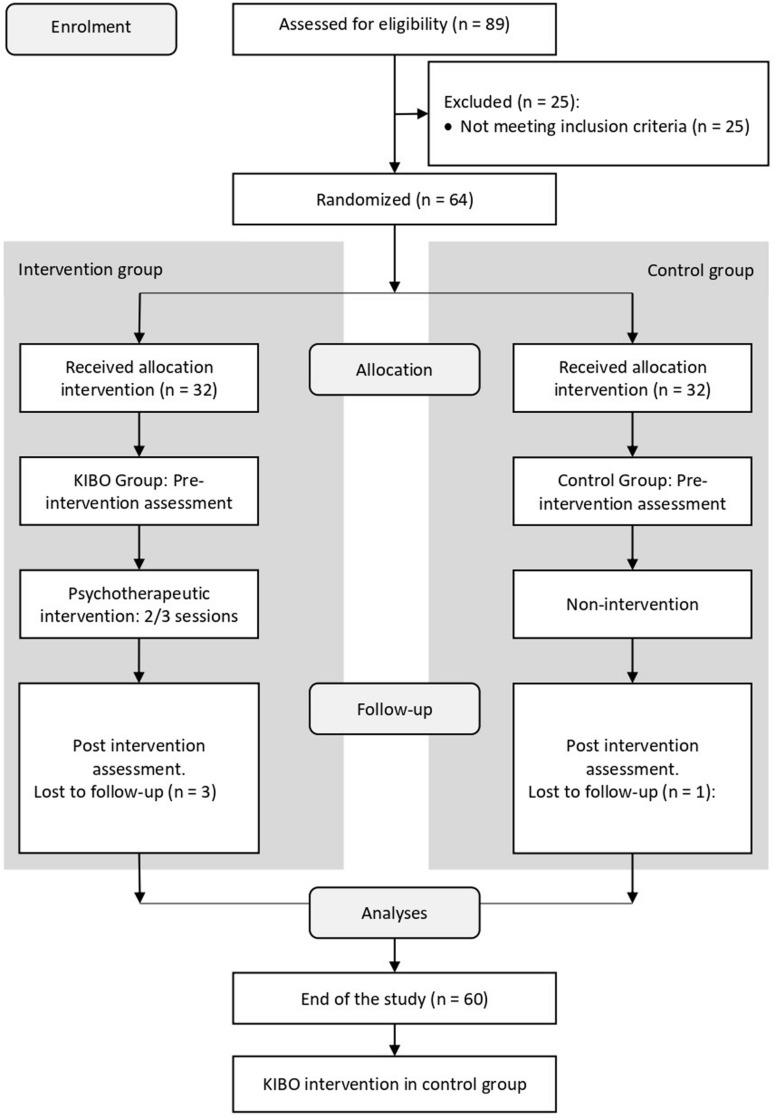
CONSORT Diagram.